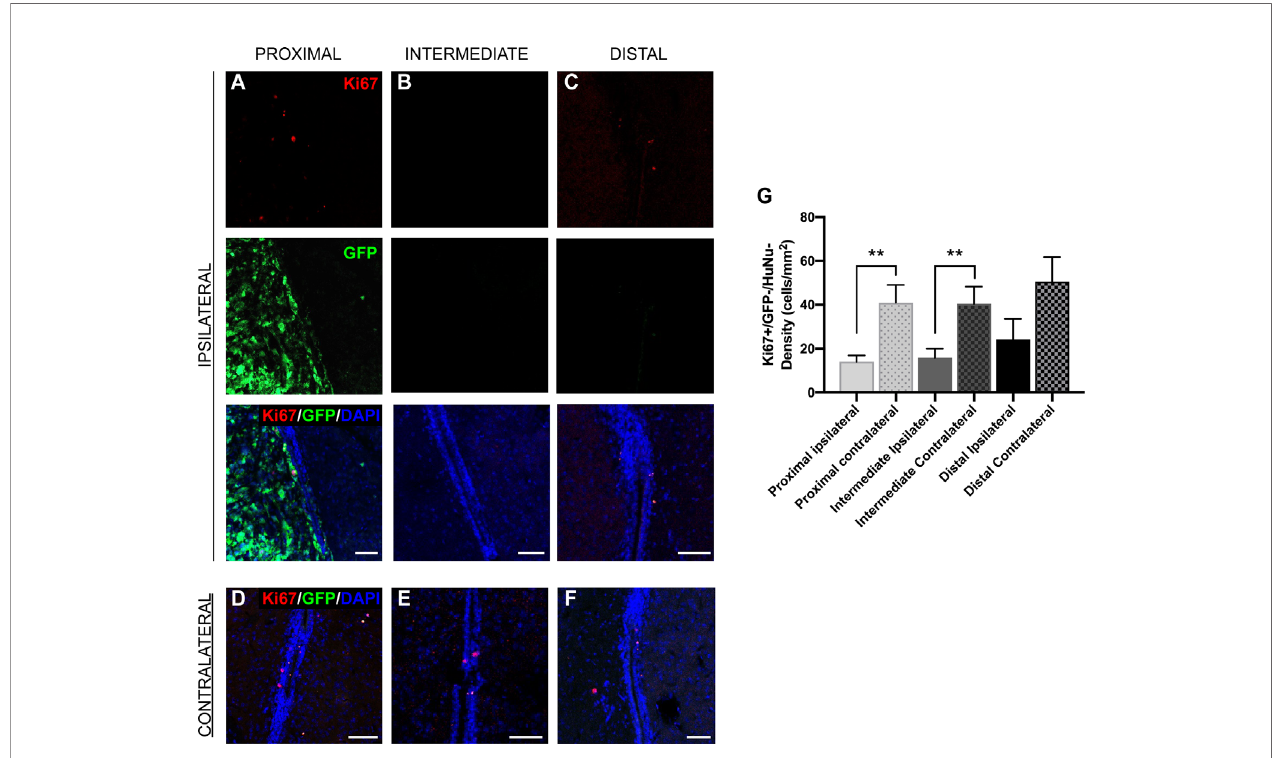
FIGURE 3 | GBM proximity to the LV negatively in fl uences Ki67 expression in the SVZ. (A – F) Representative images of immunohistochemical staining for Ki67 in GFP- cells of the SVZ (A – C) ipsilateral and (D – F) contralateral to the tumor. Red = Ki67, green = GFP, Blue = DAPI. This was compared between (A, D) LV-proximal, (B, E) LV-intermediate, and (C, F) LV-distal GBM groups. Scale bar = 50 m m. (G) Quanti fi cation of Ki67+ cell density in the SVZ comparing between the SVZ ipsilateral and contralateral to the GBM in LV-proximal (n = 6), LV-intermediate (n = 5), and LV-distal (n = 5) mice. Data are presented as mean ± SEM. ** p <